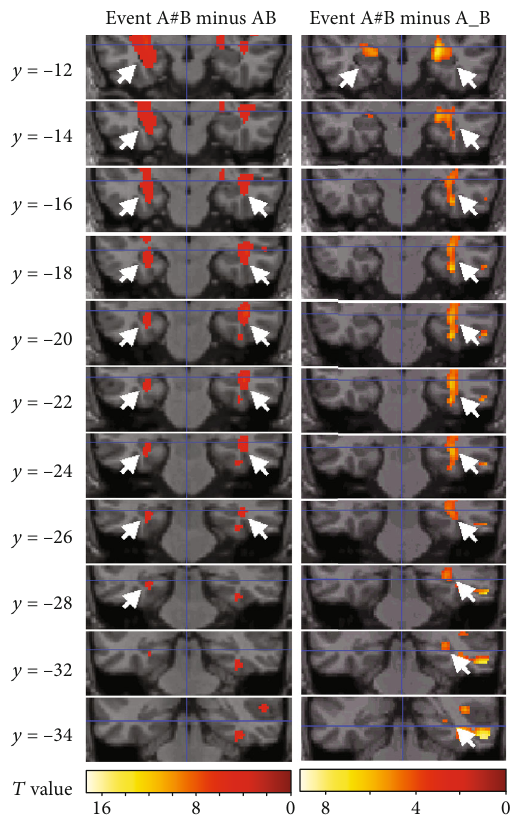
Figure 2: MTL activities shown when Event A#B was contrasted with Events AB and A_B, respectively. White arrows point to the hippocampal